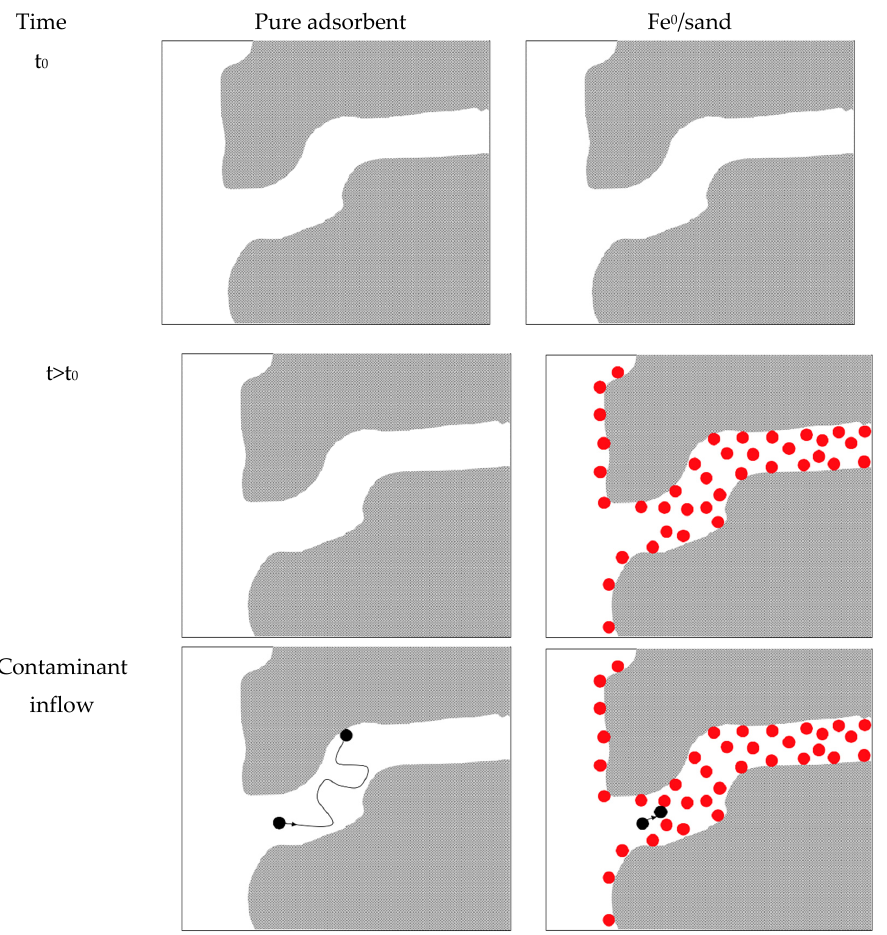
Figure 1. Schematic diagram comparing the interactions of contaminants (black points) with solid phases in a pure adsorbent system (left) and the Fe 0 -based system (right). The red points represent iron corrosion products (FeCPs) which are either coated on solids or suspended in the pore solution.